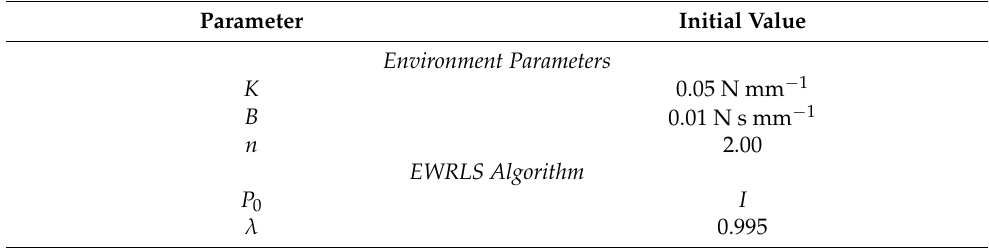
Table 2. Initial Values for the Estimation